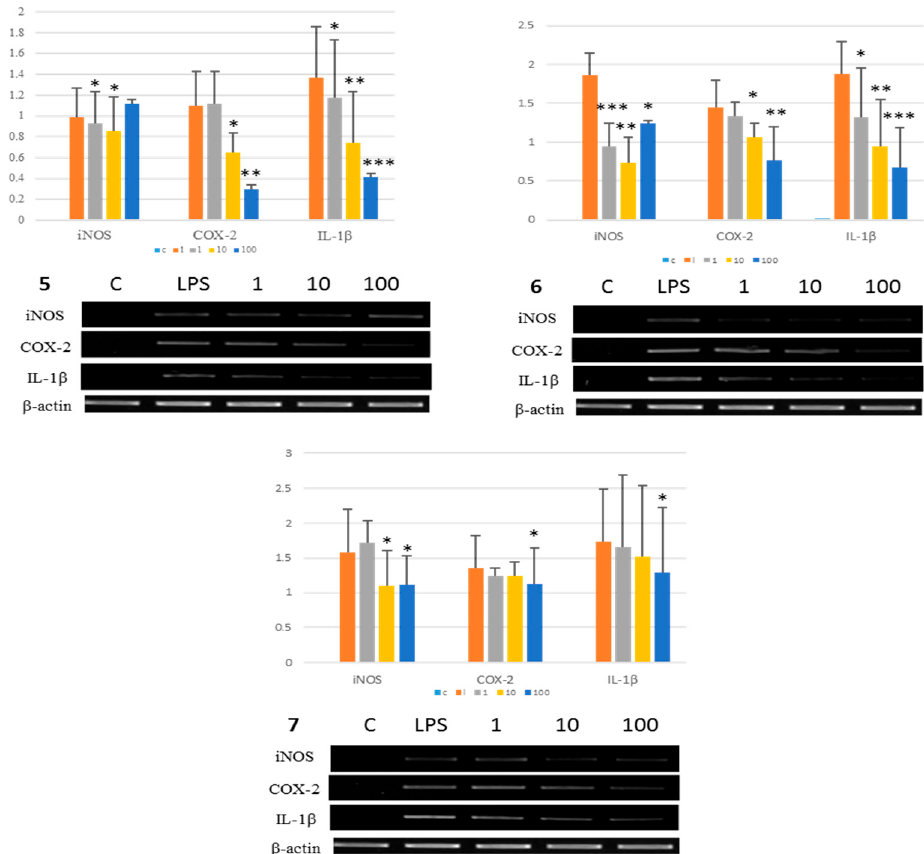
Figure 2. Inhibition of mRNA expression of iNOS, COX-2 and IL-1 β by phenolic compounds 5 – 7 from QGB. Activities were determined by RT-PCR at least three times. Concentration of LPS was 1 µ M. Values bearing different superscripts in same columns are significantly different (*: p < 0.05, **: p < 0.01, ***: p < 0.001) ( n = 3).